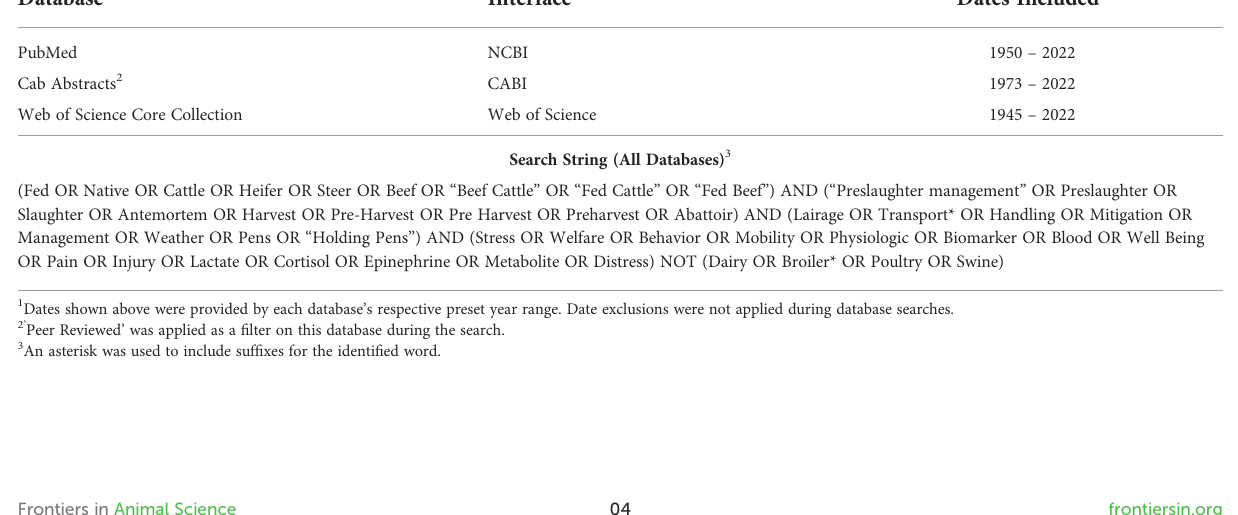
TABLE 1 Databases and search string for a scoping review covering pre-slaughter management factors and their impacts on indicators of fed beef cattle welfare.